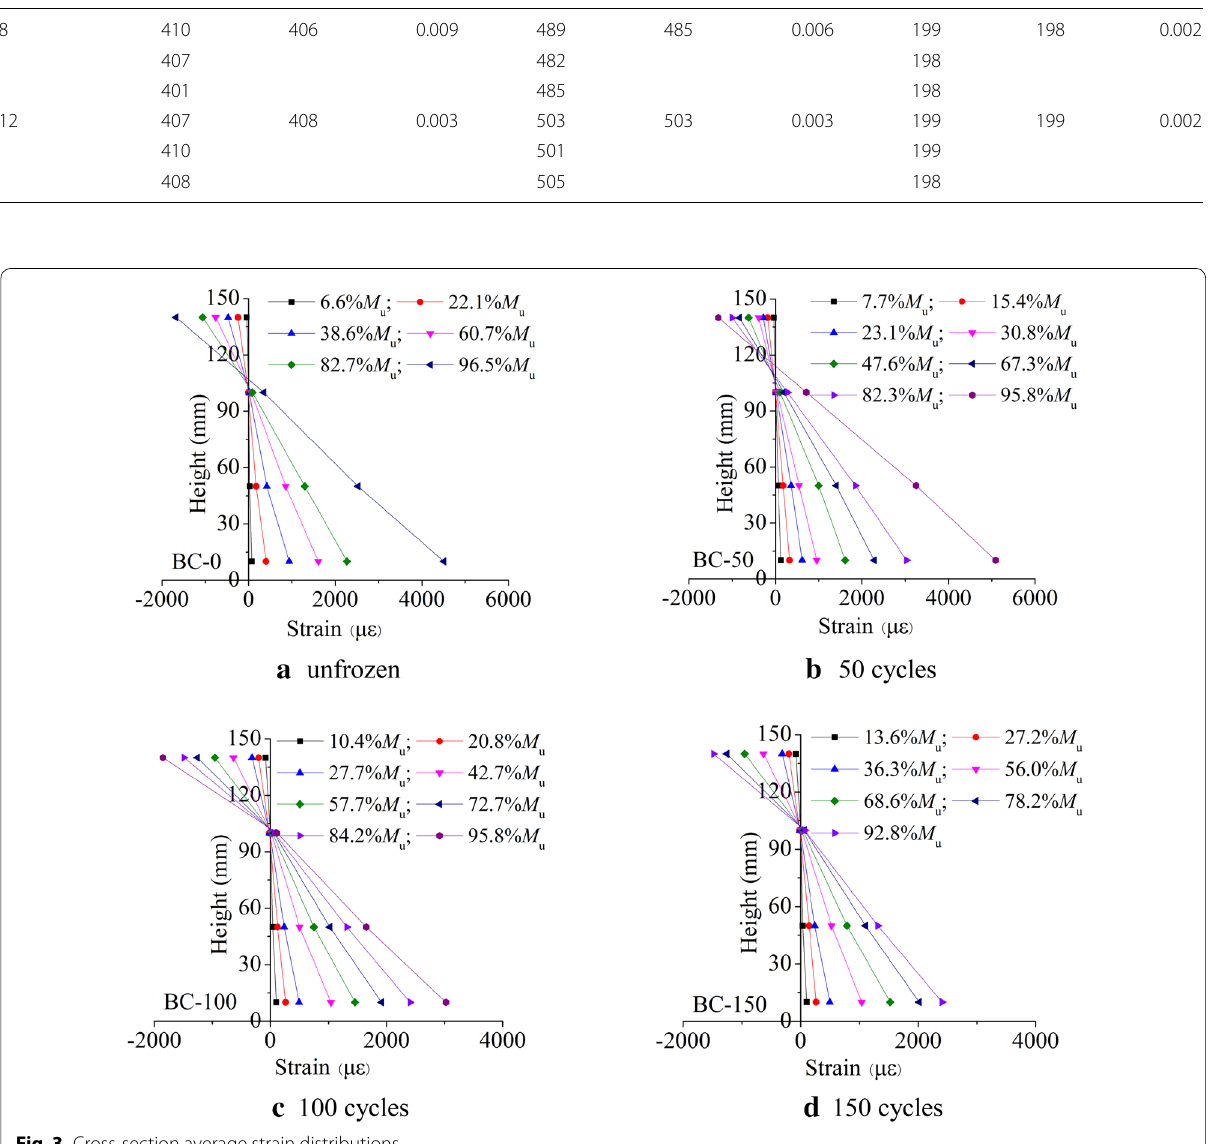
Table 5 Mechanical properties of reinforcing bars Diameter Yield strength (mm)